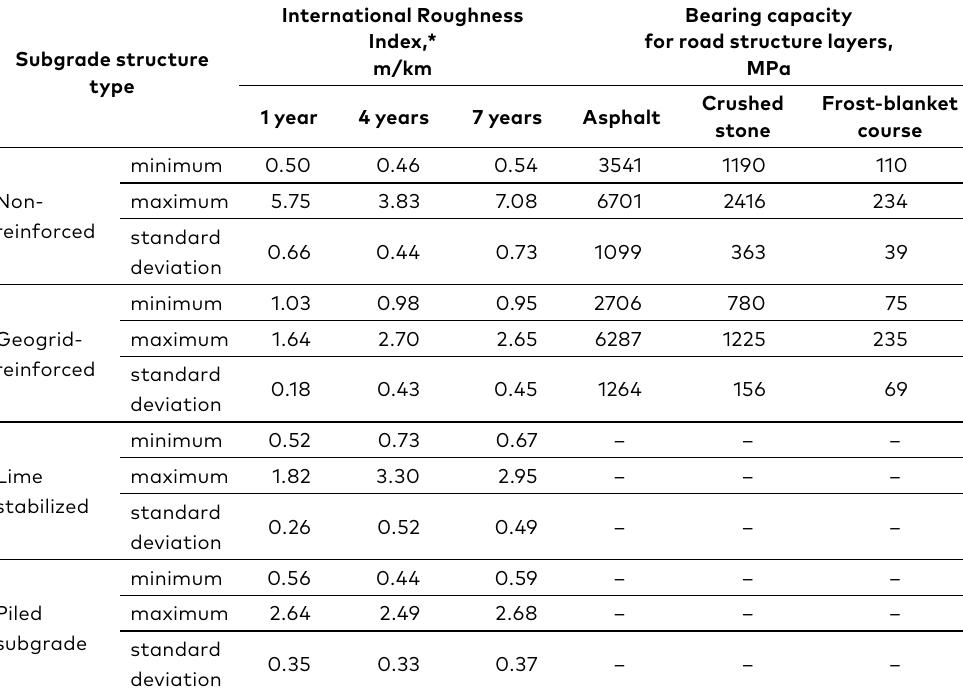
Table 4. Statistical values by subgrade structure type of measurements in the main road A6 (137.35–142.00